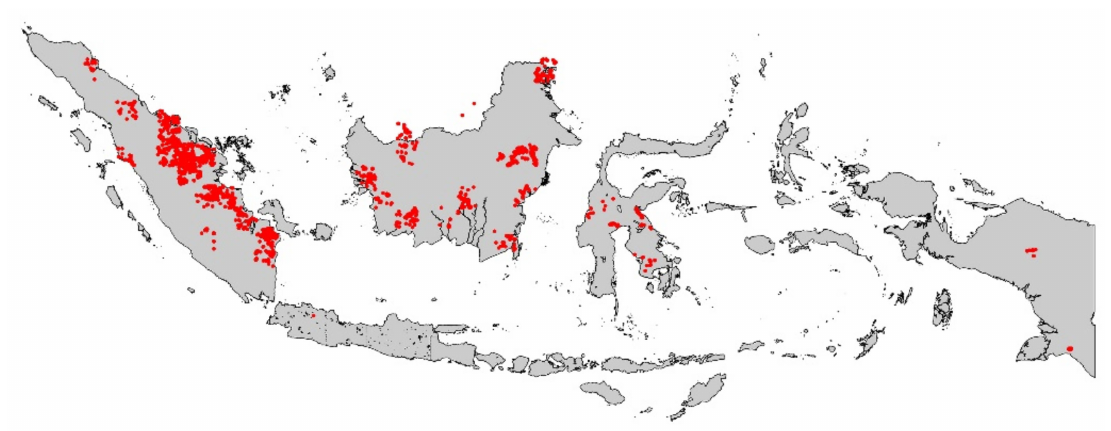
Figure 8. Deforestation hotspots (red) for 2020 derived from Landsat-8 OLI